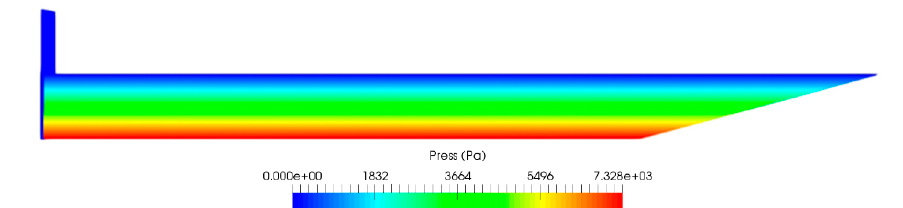
Figure 22. 3-D SPH result of hydrostatic pressure for d = 0.75 m.